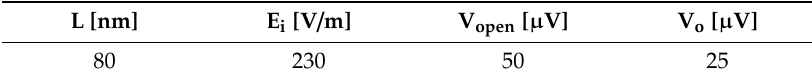
Table 3. Electric Field, V open and Output Voltage V